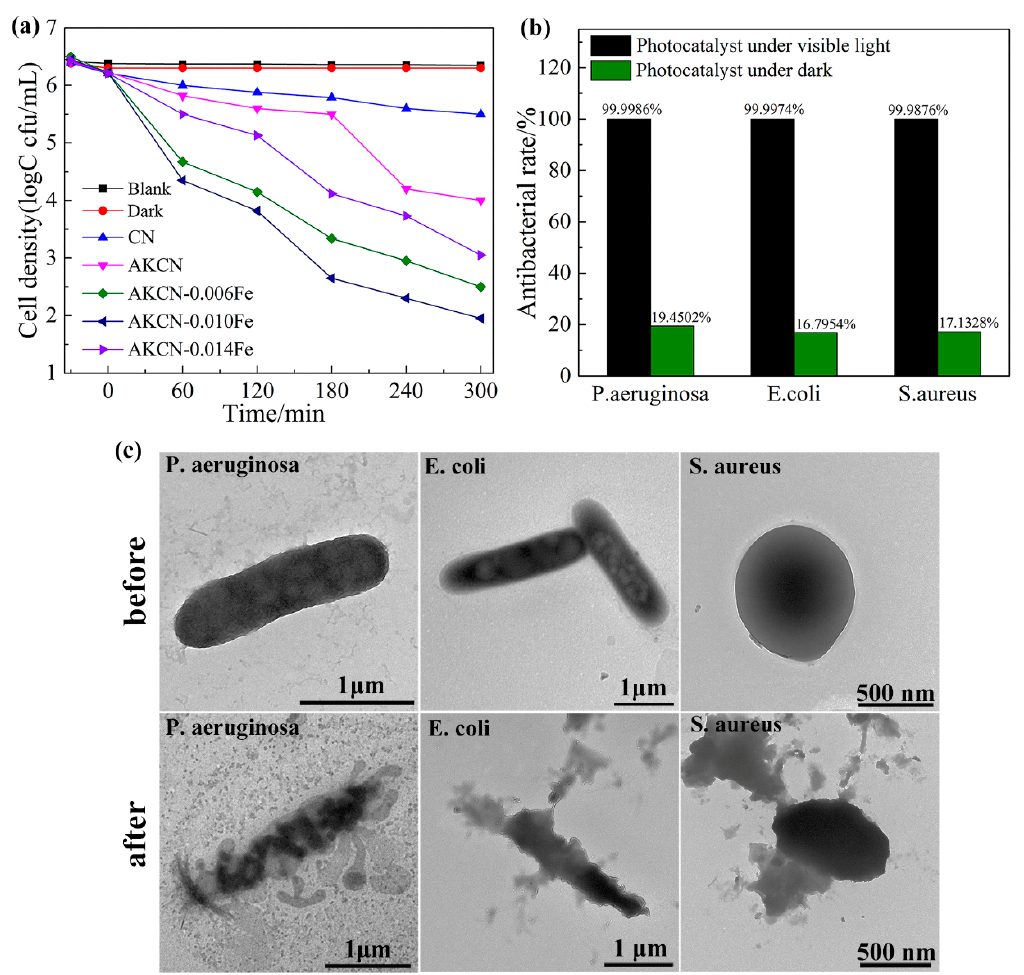
Figure 8. ( a ) Survival curves of P. aeruginosa as a function of the as-prepared semiconductor photocatalysts under visible light and ( b ) photocatalytic antibacterial rate histogram towards P. aeruginosa, E. coli , and S. aureus under visible light. ( c ) TEM images of the P. aeruginosa, E. coli , and S. aureus cell before and after photocatalytic reaction.